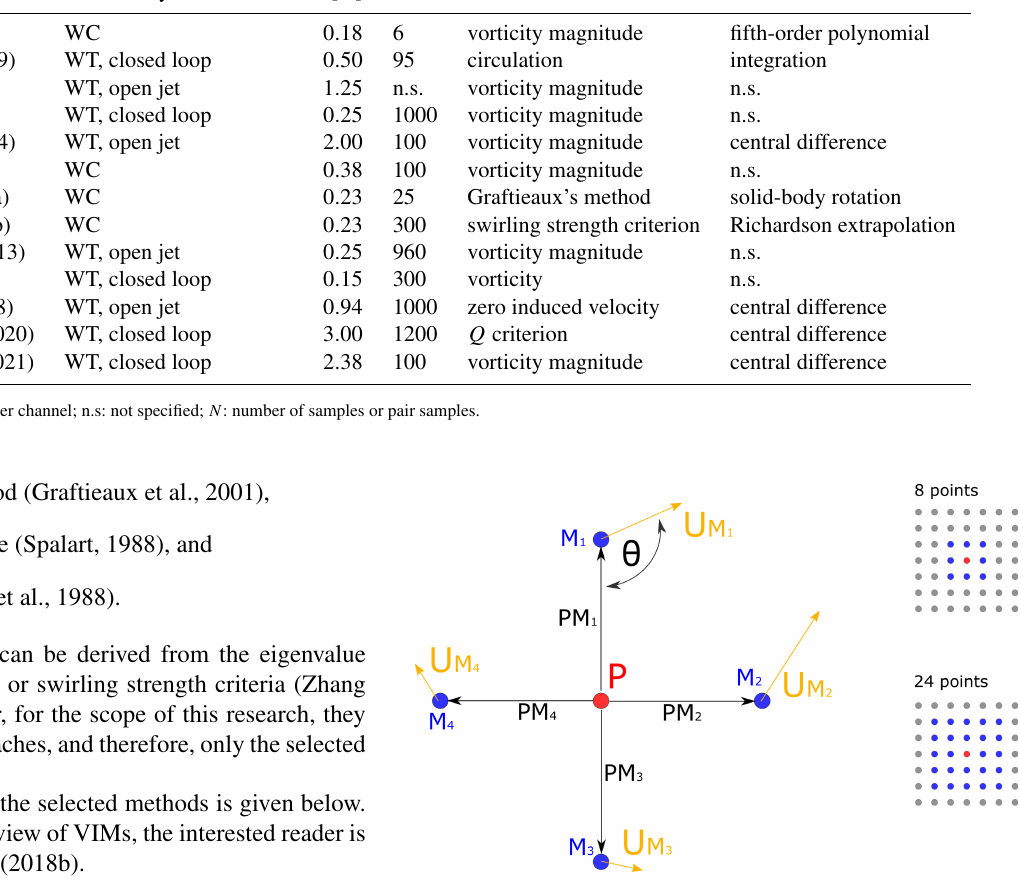
Figure 1. Sketch of Graftieaux parameters in (cid:48) 1